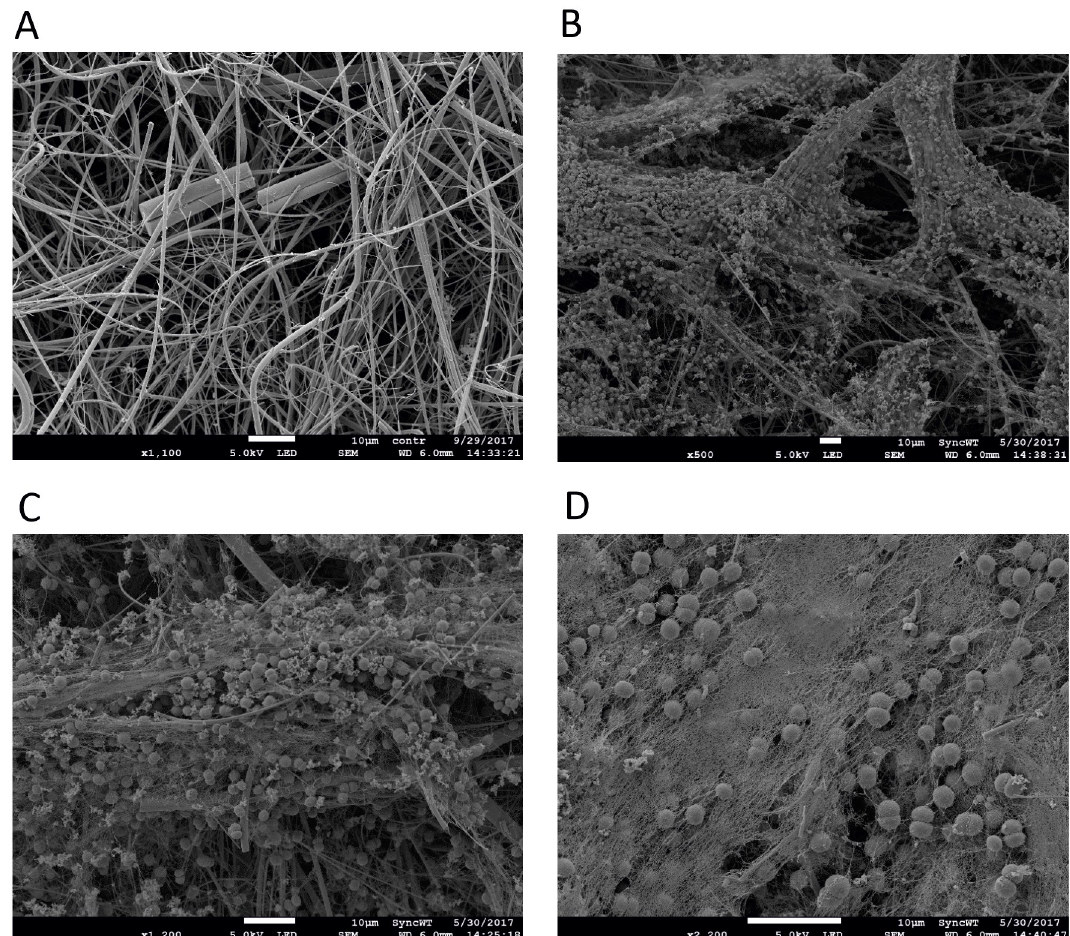
Fig 2. SEM of biofilm formation by Synechocystis on glass microfiber filters after 7 days of incubation. (A) control filter at 1100X magnification, (B) biofilm structure formation at 500X magnification, (C) at 1200X magnification, (D) at 2200X magnification (Bar is 10 μ m in each